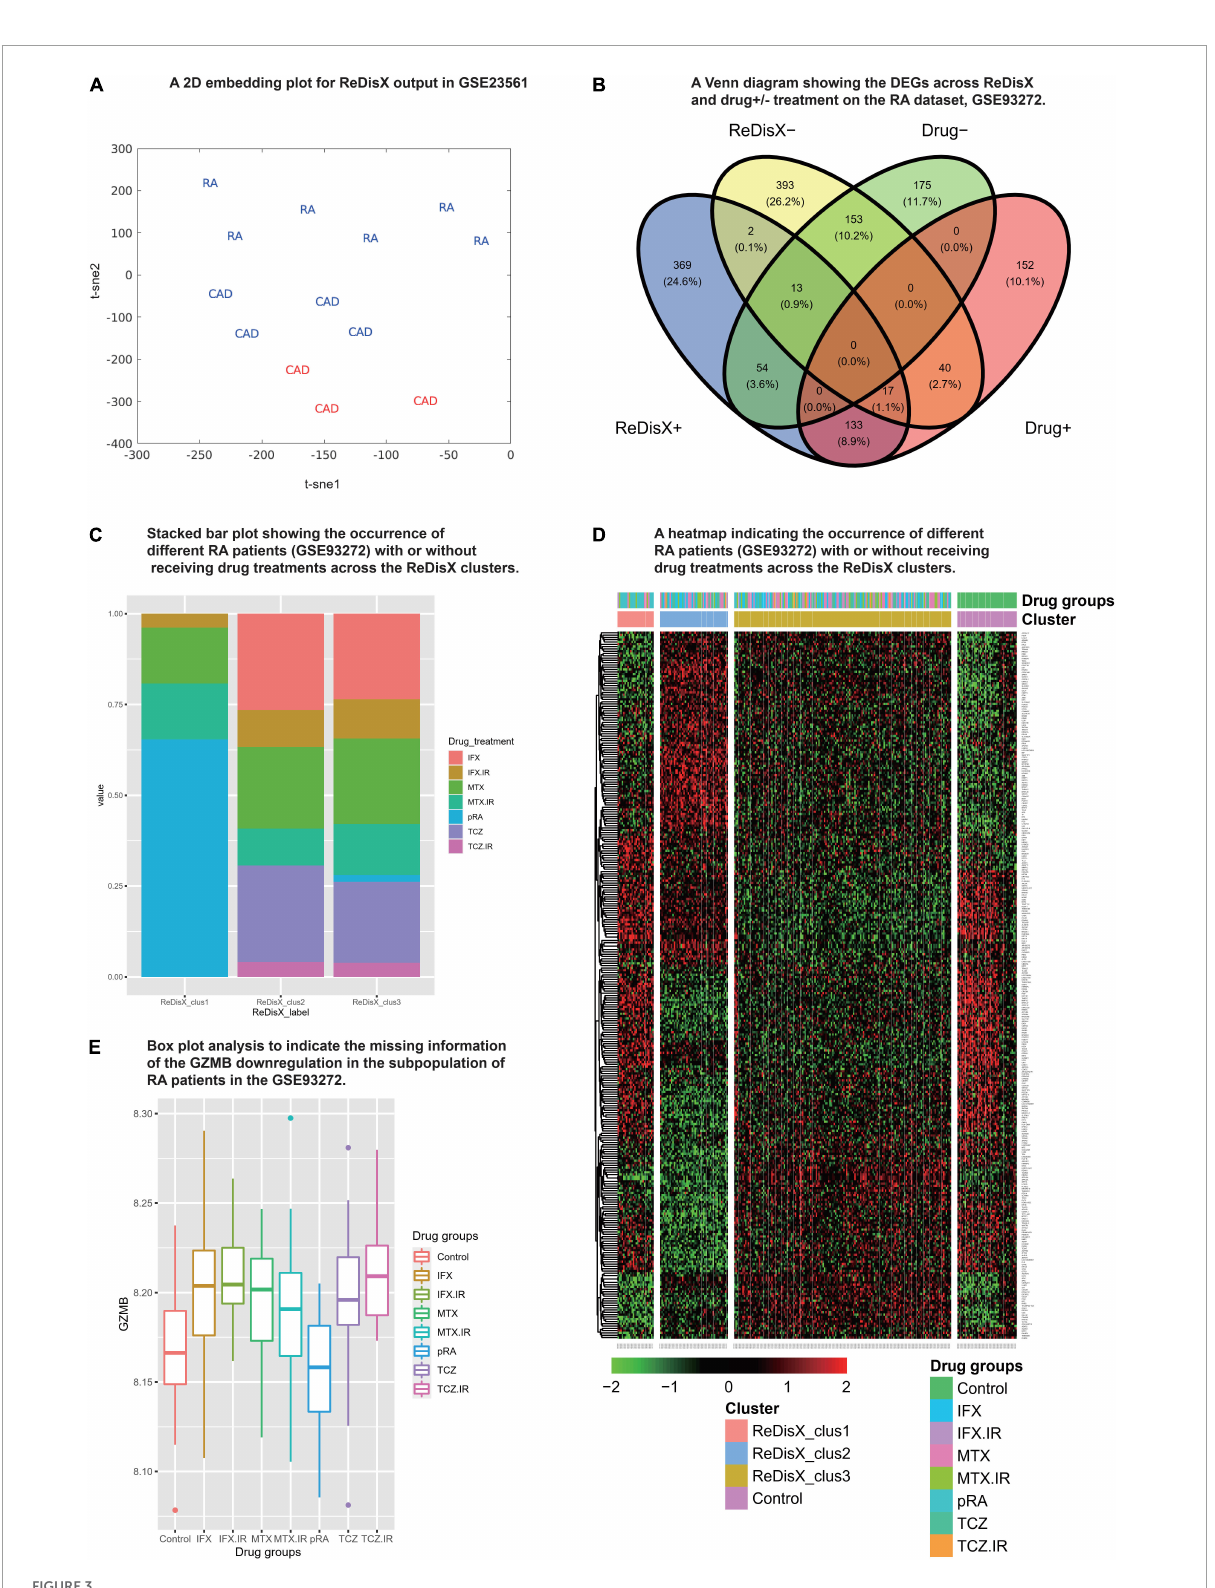
FIGURE3 Cross-dataset validation of ReDisX performance to identify the hub genes, and generosity of ReDisX to identify DEGs. This figure comprises two distinct sections, (A) indicates the cross-dataset validation of ReDisX performance to identify the hub genes from GSE23561; and (B–E)